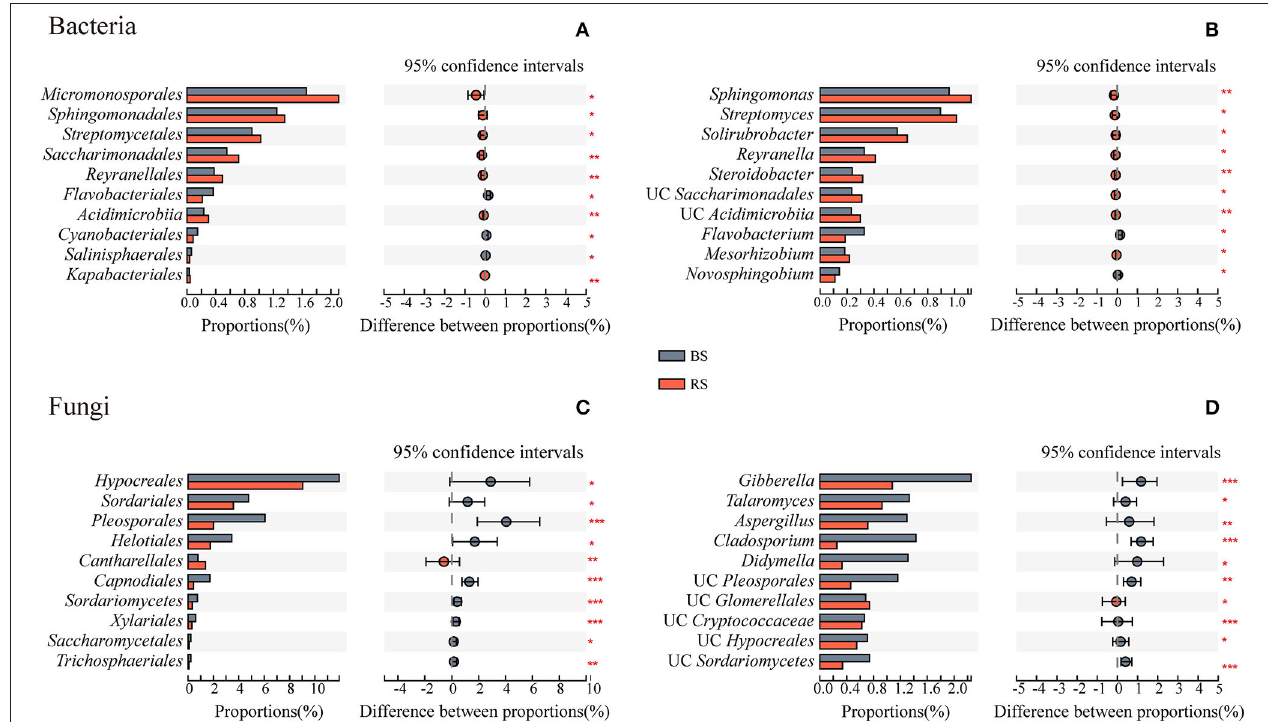
FIGURE 4 | Taxa differences of bacteria and fungi between the bulk soil and the rhizosphere soil. (A,C) and (B,D) Show the microbial differences at the order and genus levels, respectively. The vertical axis shows taxa at order level with mean sums in the top 10, and different colored boxes indicate different groups. The horizontal axis represents the average relative abundance of taxa. *, **, and *** Indicate significant differences between the two groups, 0.01 < p < 0.05, 0.001 < p < 0.01, and p < 0.001, respectively. BS and RS, bulk soil and rhizosphere soil, respectively. UC, unclassified.